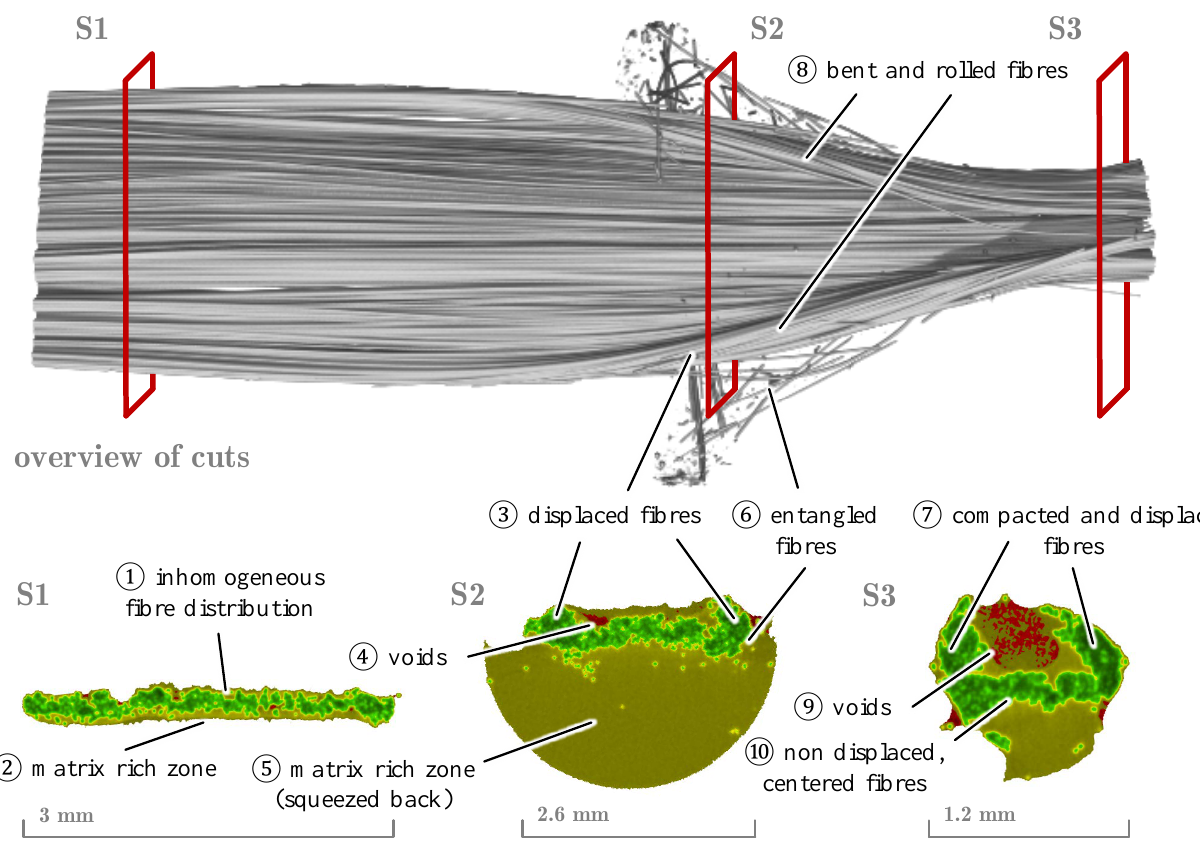
Figure 14. CT reconstruction data and section cuts of deformed GF-PP 5mm/s and 200°C, D fe =